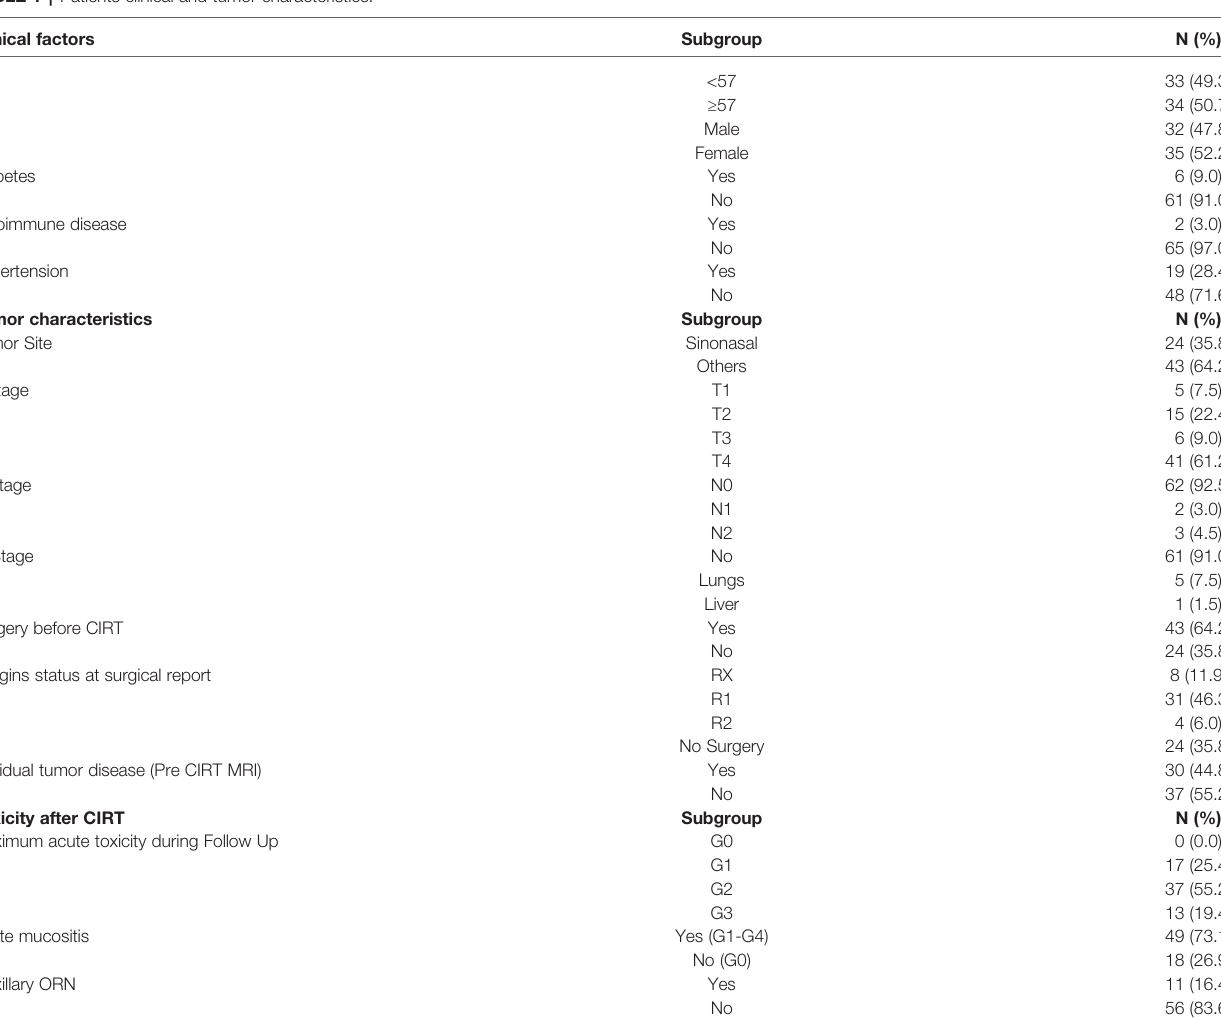
TABLE 1 | Patients clinical and tumor